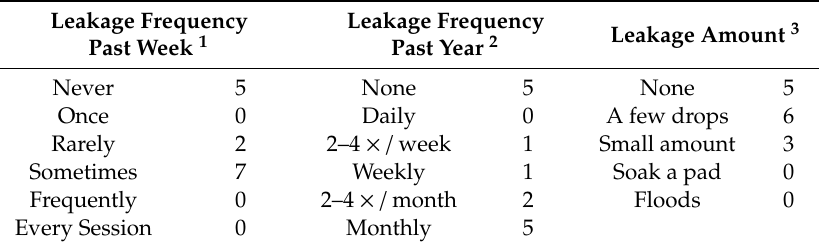
Urinary incontinence episode frequency and amount of urine leakage reported by survey